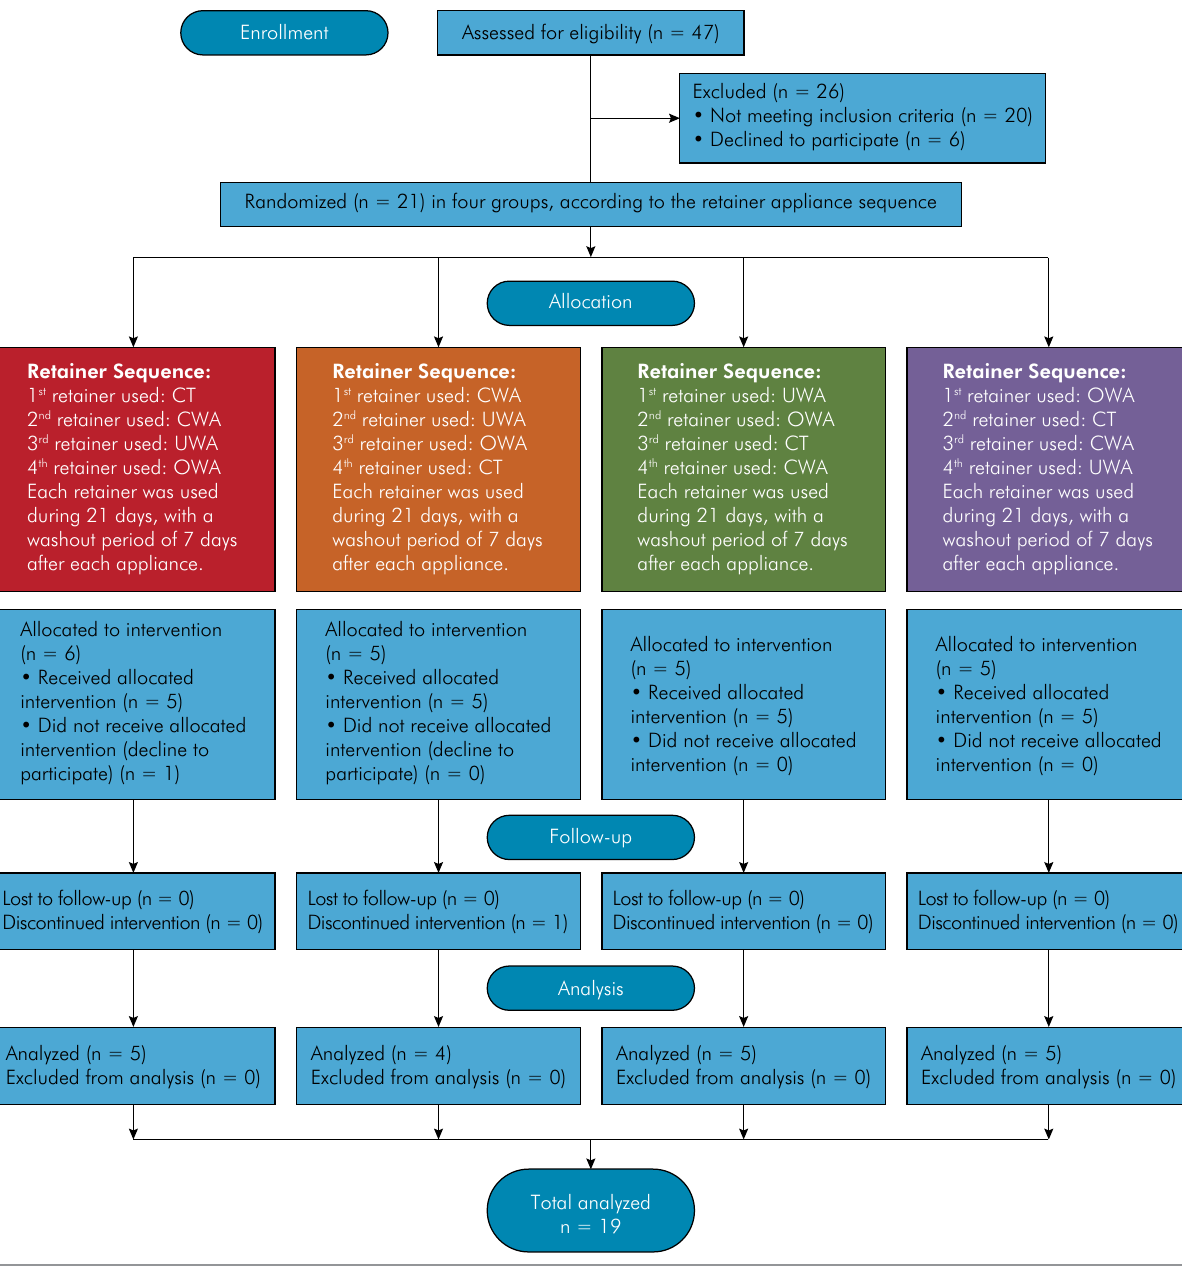
Figure 2. Flow diagram of study recruitment and interventions. CWA: Conventional Wrap-Around retainer; OWA: Wrap-Around retainer with an opening; UWA: “U” Wrap-Around retainer; CT: Clear Thermoplastic